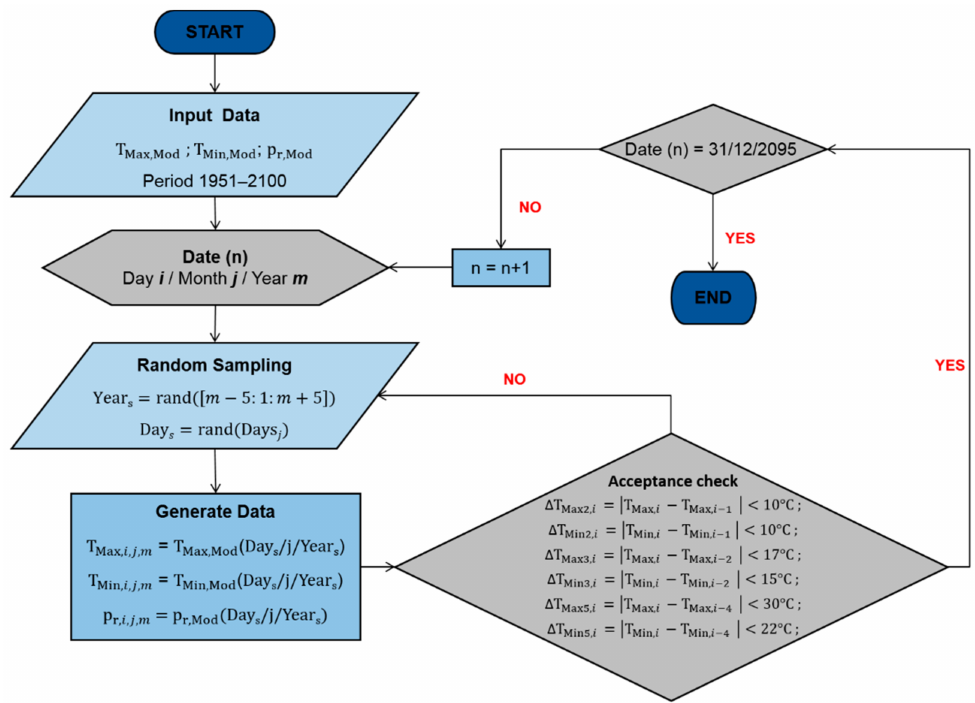
Figure 1. Implementation scheme of the weather generator